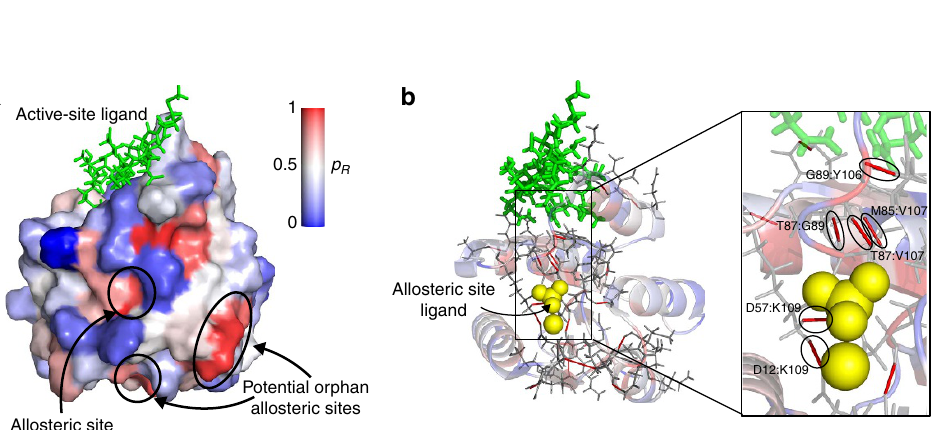
Figure 2 | Allosteric phosphorylation site in CheY is identified by its high propensity. ( a ) Residue quantile scores p R are mapped onto the surface of CheY. The allosteric phosphorylation residue D57 is identified as a hotspot. We identify two other distant sites, which could serve as potential orphan targets for allosteric effectors. ( b ) The top 3% of bonds by quantile score (that is, p b Z 0.97) are indicated on the structure. The blow-up shows high quantile score non-covalent bonds that form propagation pathways between the allosteric ligand (yellow spheres) and the ligand-binding site